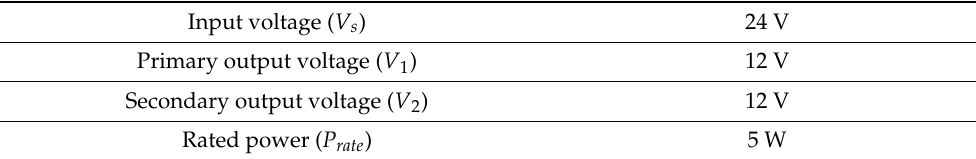
Table 1. System specification.